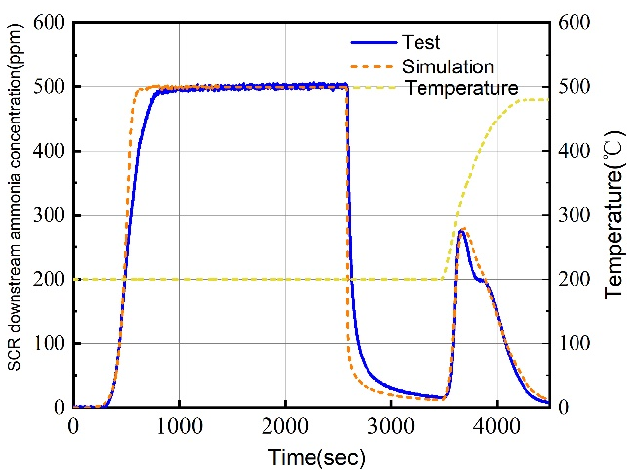
Figure 4. Schematic diagram of E-R mechanism.